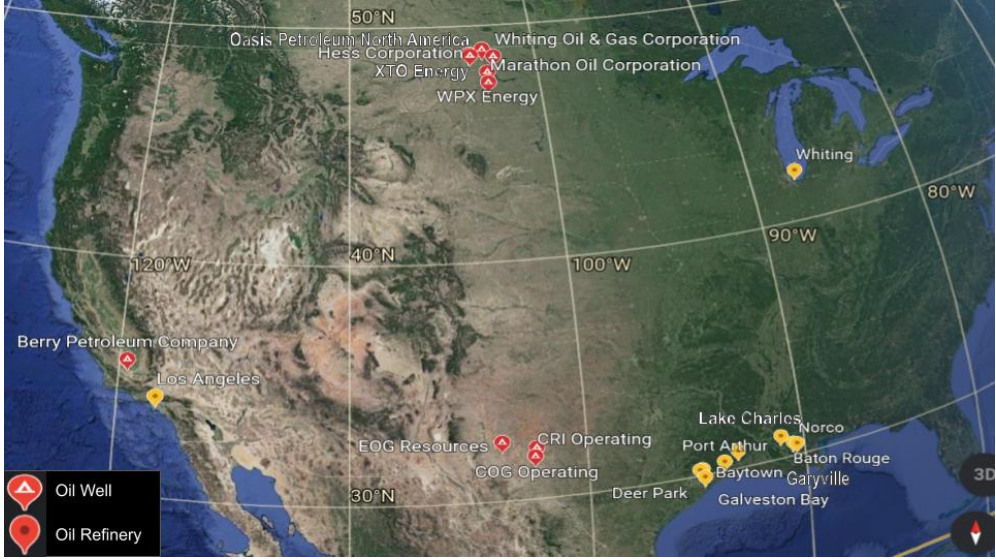
Figure 14. Map of Top CO 2 Emission Bottlenecks- Oil Extraction & Refining Facilities in the United States (Generating using Google Earth).